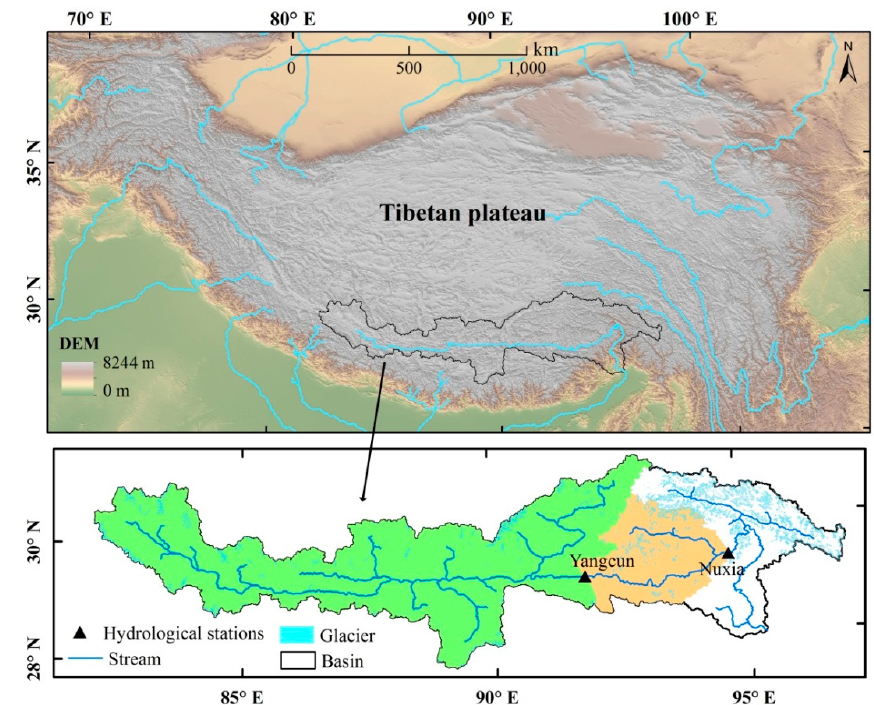
Figure 1. Locations of the Upper Brahmaputra (UB) river basin and the two hydrological stations (Yangcun and Nuxia).